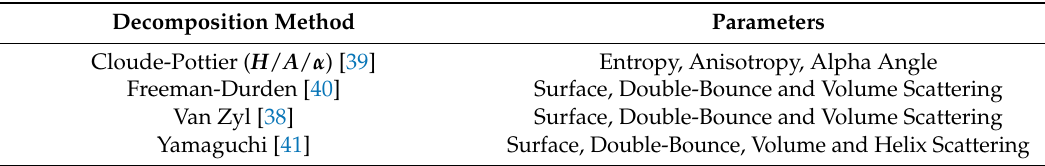
Table 4. Polarimetric Target